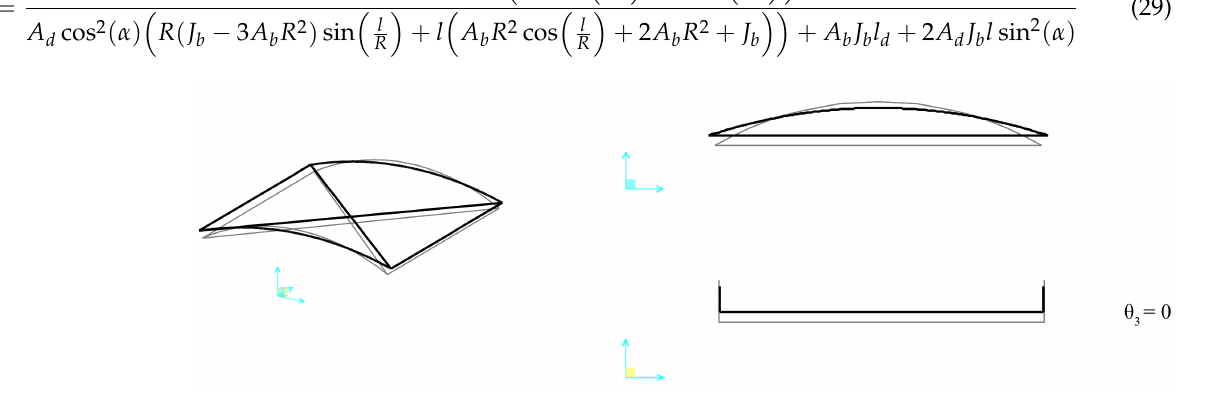
Figure 9. Deformed configuration of the problem